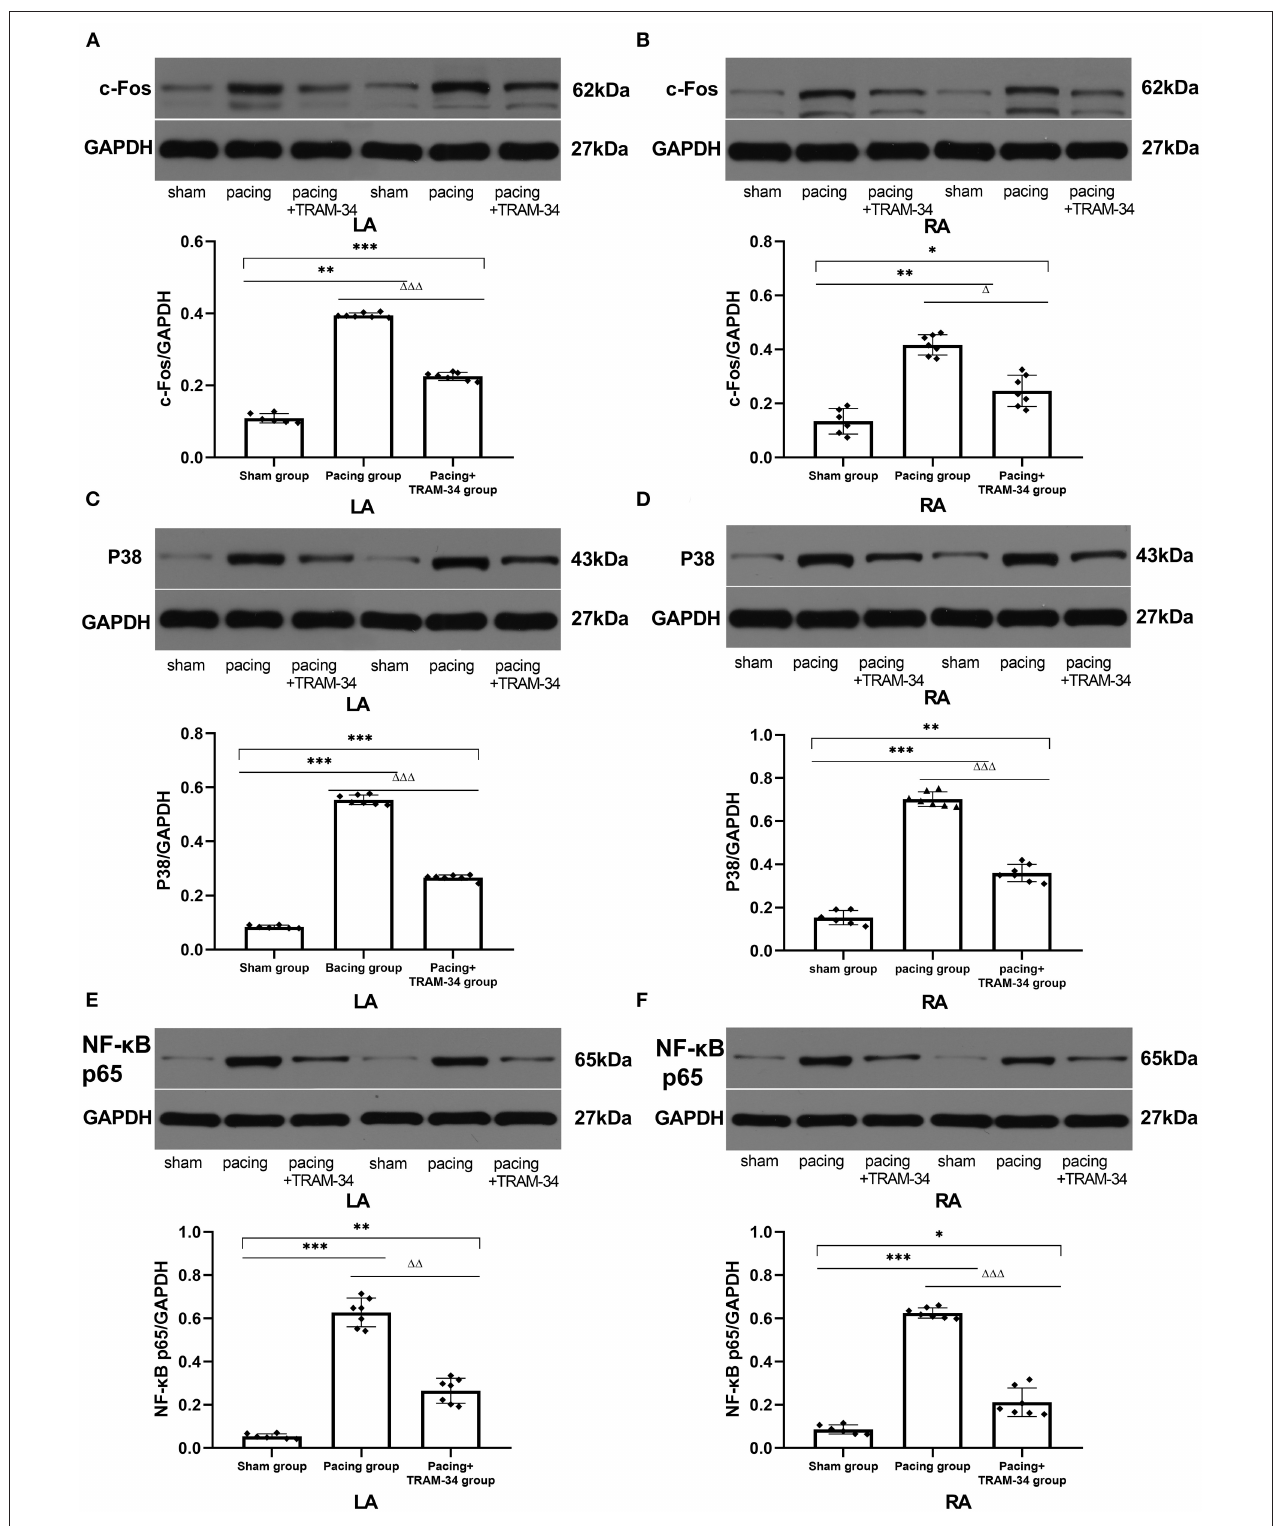
FIGURE 4 | Expression of c-Fos, p38, and NF- κ B p65 in all groups. (A–F) The levels of c-Fos, p38, and NF- κ B p65 in both the LA and RA were markedly higher in the pacing group, compared with the sham or pacing + TRAM-34 groups. The levels of c-Fos, p38, and NF- κ B p65 in both the LA and RA were higher in the pacing + TRAM-34 group than in the sham group. P * < 0.05 vs. the sham group, P ** < 0.01 vs. the sham group, P *** < 0.001 vs. the sham group. P 1 < 0.05 vs. the pacing group, P 11 < 0.01 vs. the pacing group, P 111 < 0.001 vs. the pacing group. In our experiment, the same GAPDH was used for TNF- α , MCP-1, and the same GAPDH was used for IL- β , p38, c-Fos. NF- κ B, nuclear factor kappa-B; LA, left atrium; RA, right atrium.